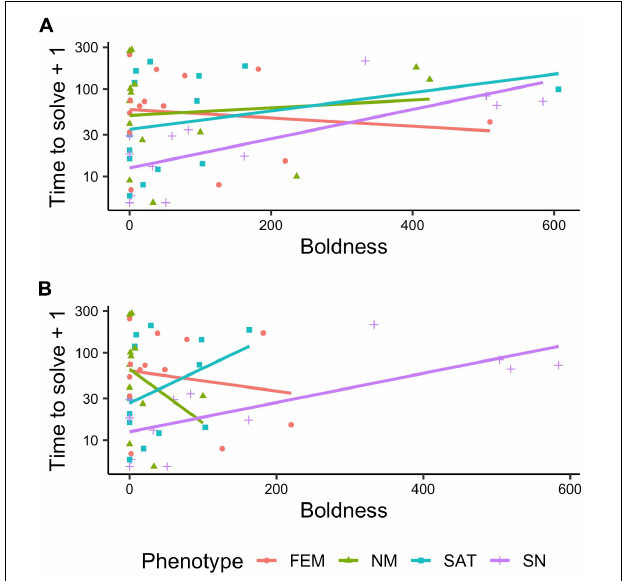
FIGURE 3 | (A) Relationship between boldness and problem-solving speed differs by phenotype. The association between boldness tendencies [x axis, as measured via time (seconds) in white zone of a scototaxis assay] and problem-solving speed (time in seconds) in initial detour reaching task (y axis) for each phenotype: sneaker males (magenta), satellite males (blue), nesting males (green) females (orange). The significant interactions identified with GLMM modeling of boldness (time in white zone of scototaxis trials) by phenotype ( p < 0.05) that predicted (A) variation in problem-solving speed (detour task) including all datapoints, (B) with outliers